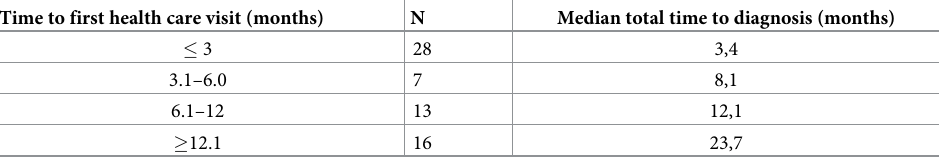
Table 2. Median total time to diagnosis (from first symptom recognition to diagnosis) related to time to first healthcare visit in months. Time to first health care visit (months)